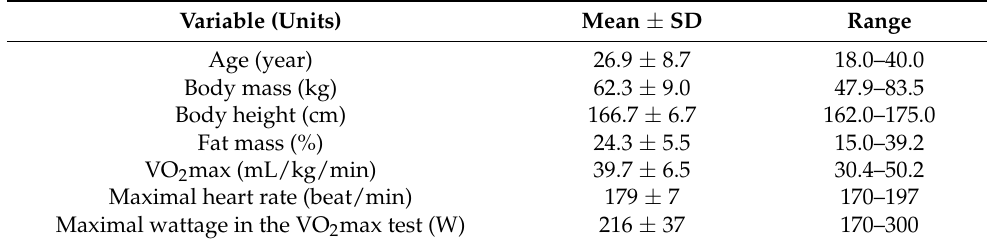
Table 1. Participants’ age, morphological characteristics, and values at the end of a VO 2 max test on a cycle ergometer. Data are presented as mean ± standard deviations (SD) with minimal and maximal values